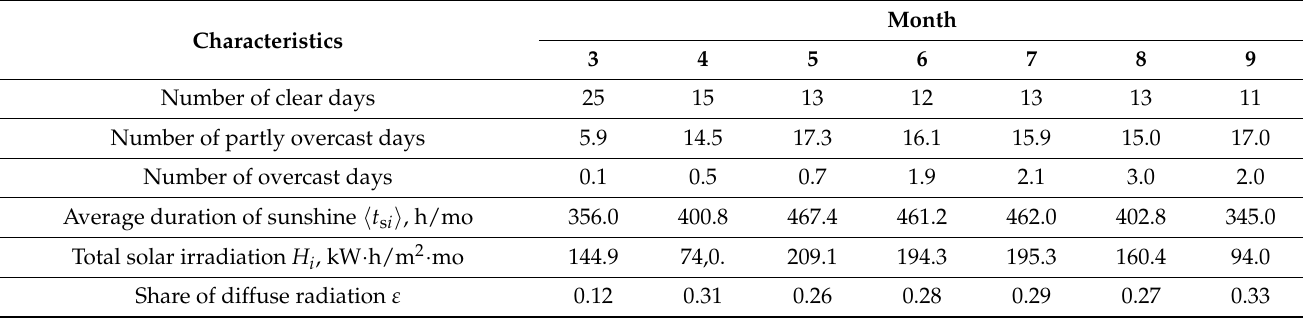
Table 3. Number of clear, partly overcast and overcast days, average duration of sunshine (cid:104) t s i (cid:105) , solar irradiation on horizontal surfaces, H i , during a 10 h period (from 07 a.m. to 05 p.m.), and share of diffuse radiation, ε , in the sunny months of the